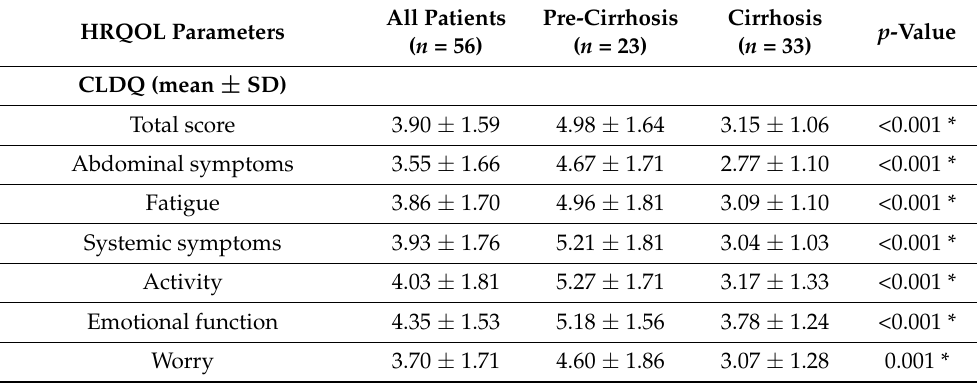
Table 6. Assessment of QOL among patients with